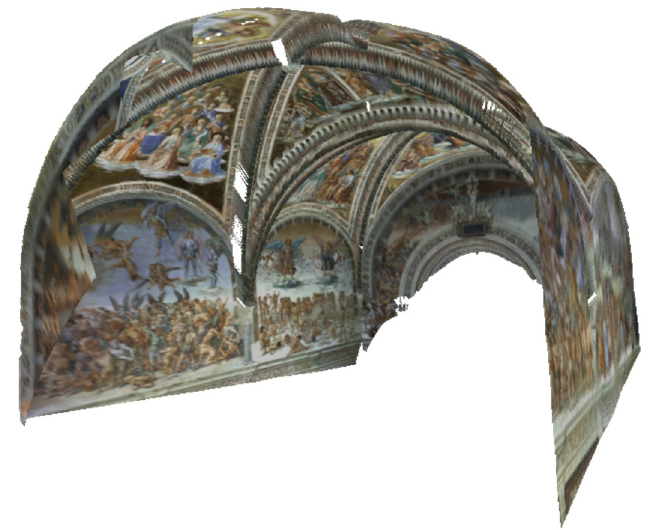
Figure 11. 3D model of the San Brizio Chapel obtained with the RGB-ITR scanner. The colors are uniform without shadows, unlike photographs (Figure 9). (Elaboration carried out by ENEA team with the custom software itrAnalyzer).